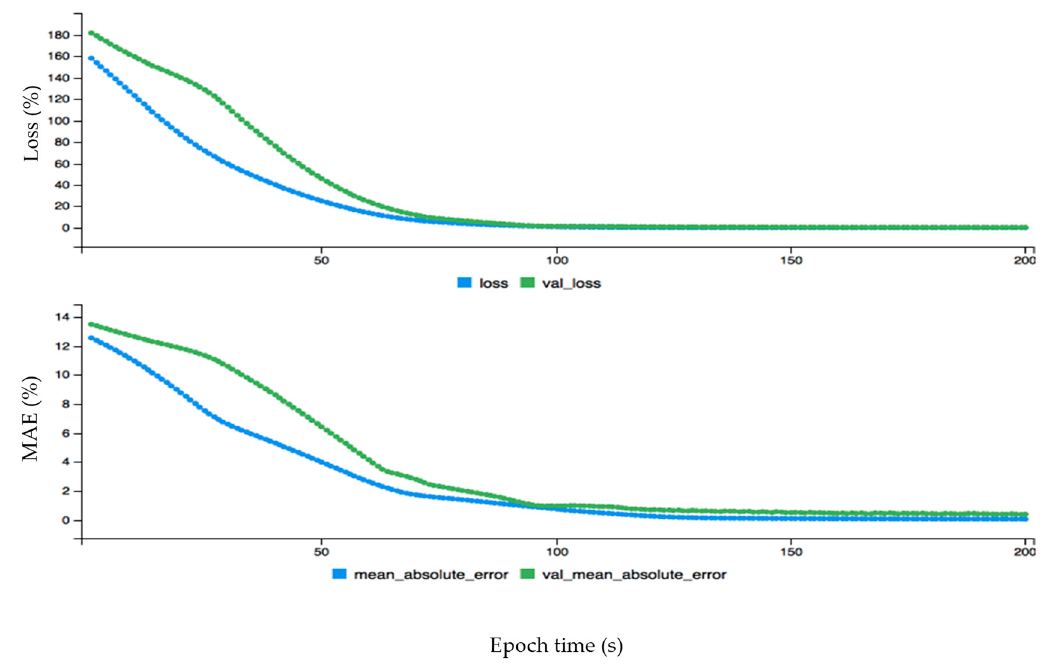
Figure 7. The dynamic plot of forecasting error before fine-tuning configuration for monthly wind data.